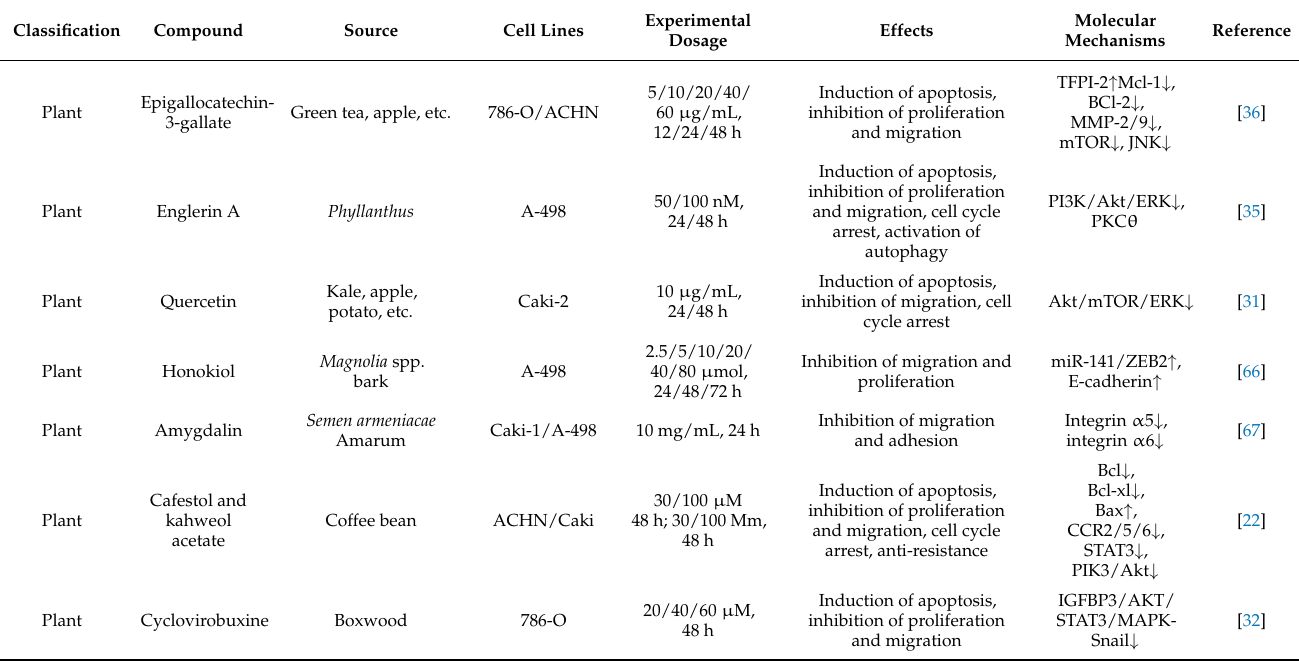
Table 3. Natural products showing cancer-intrinsic inhibition (major in motility inhibition) in renal cell